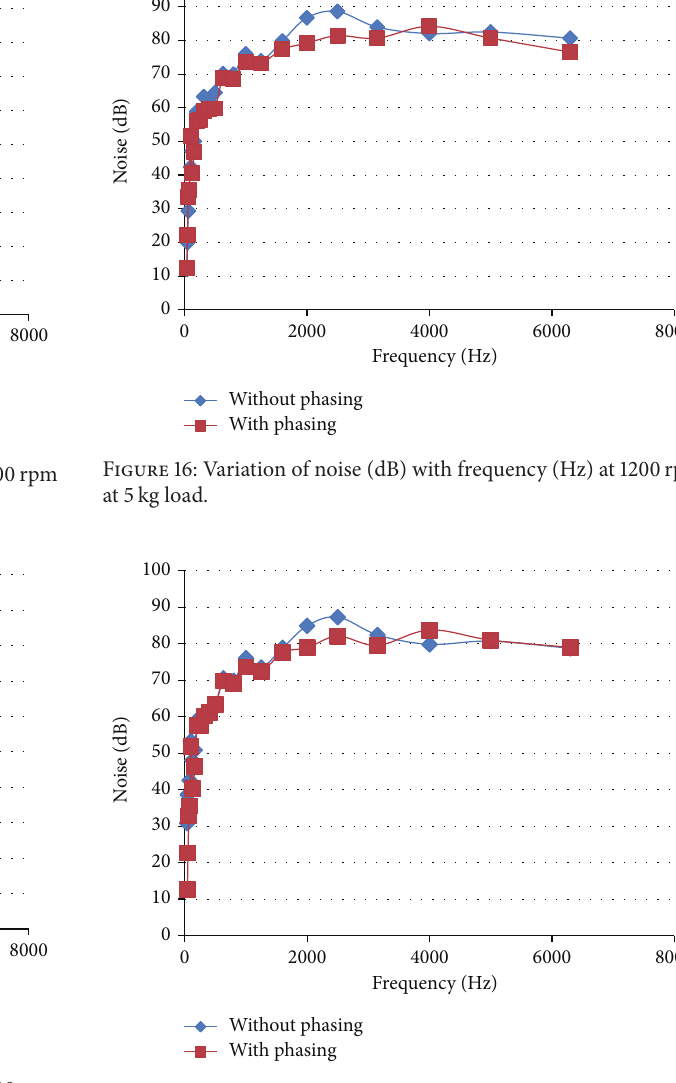
Figure 15: Variation of noise (dB) with frequency (Hz) at 1200rpm at 4 kg load.